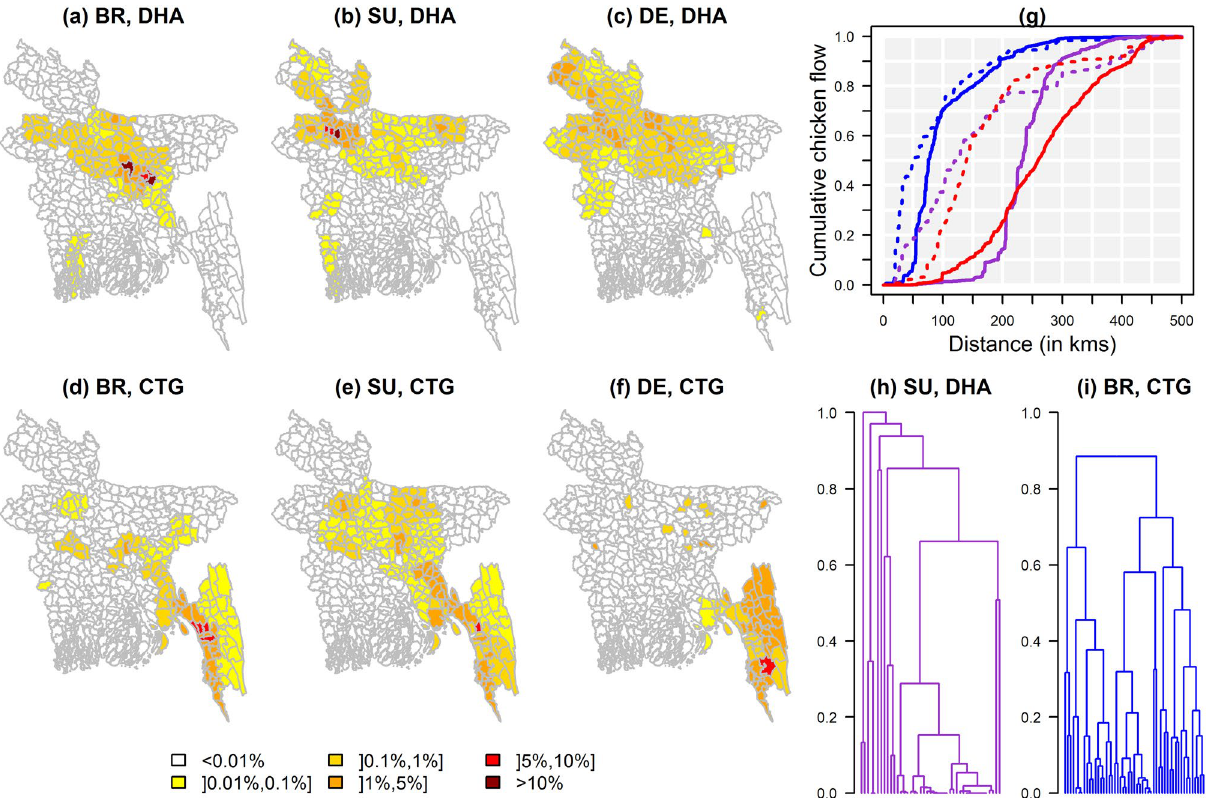
Figure 2. Origins of chickens sold in Dhaka and Chattogram markets. Catchment areas of Dhaka ( a–c ) and Chattogram ( d–f ) are shown for broilers ( a,d ), sonalis ( b,e ) and deshis ( c,f ); ( g ) cumulative distribution of broilers (blue), sonalis (purple) and deshis (red) sold in Dhaka (solid lines) and Chattogram (dashed lines) according to the distance over which they were transported, from farms to their terminal market; ( h,i ): hierarchical clustering of Dhaka and Chattogram markets based on the similarity of their catchment areas for sonalis and broilers, the most commonly chicken types in each city, respectively; the distance between any two markets (y-axis) was 1-[Pianka index], with a value of 0 meaning that two markets had similar catchment areas, and a value of 1 that those areas did not overlap. SO, DHA DE, DHA BR, CTG SO, CTG DE,